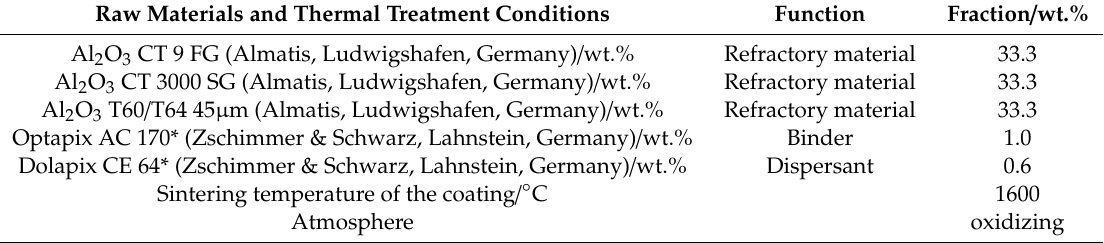
Table 1. Composition and thermal treatment conditions for the preparation of Al 2 O 3 coating. (* based on sum of solids) .